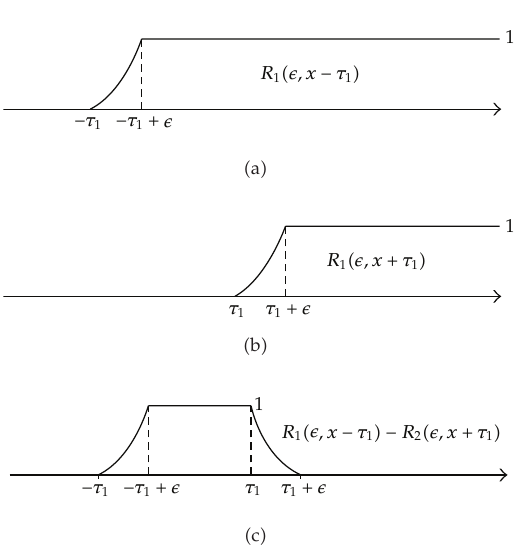
Figure 1: Sketch of a representative of step soliton generalized